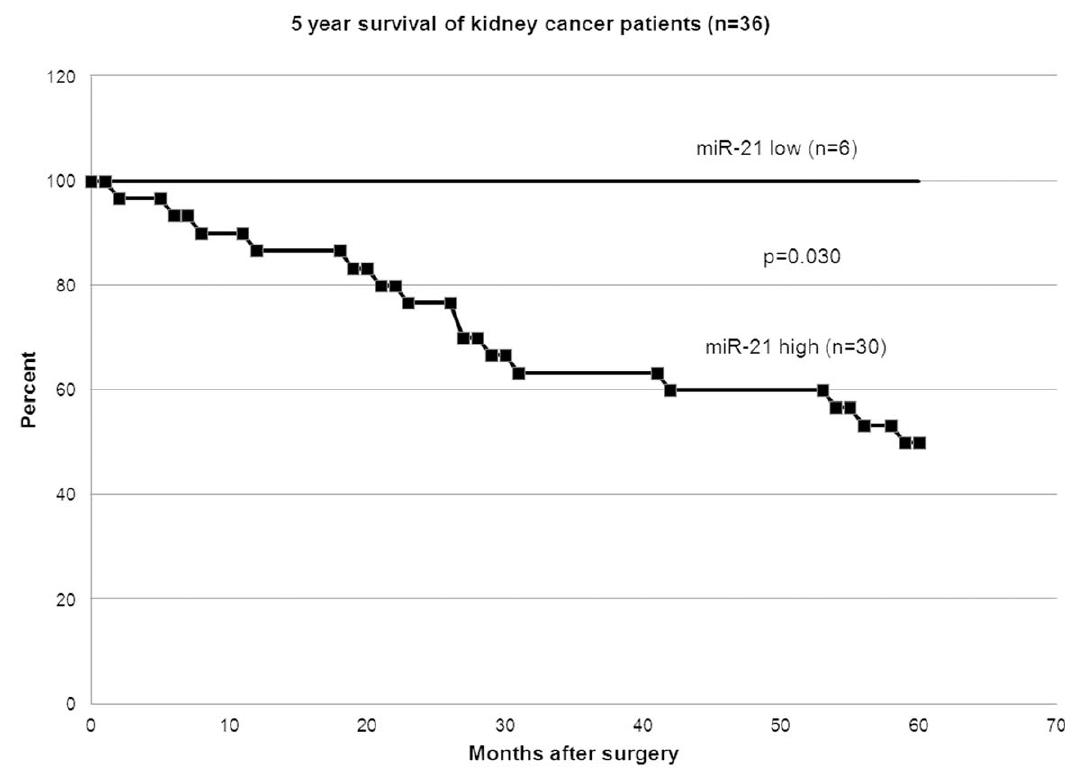
Figure 1. Correlation of miR-21 expression with 5 year survival of renal cell carcinoma patients.